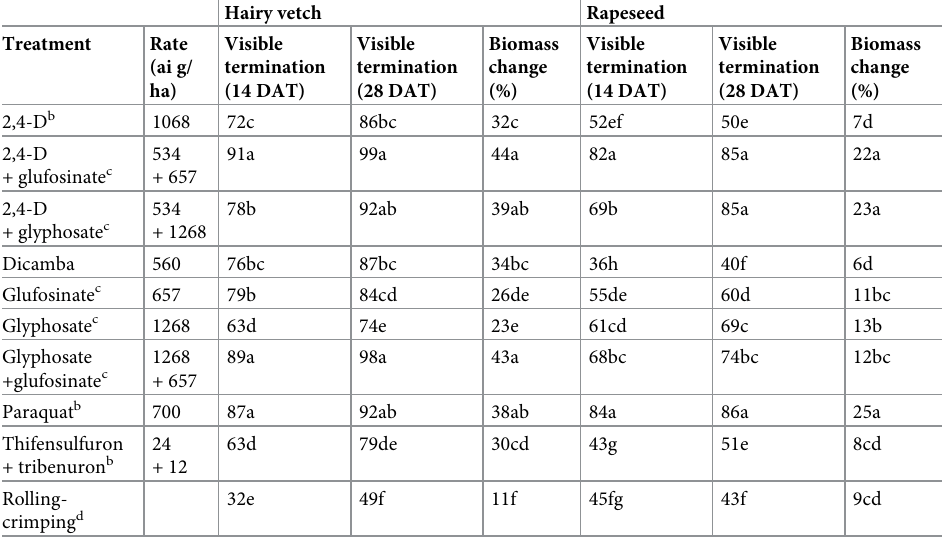
a Visible termination and biomass reduction means with a column followed by the same letter are statistically similar to each other at 5% level of significance b Crop oil concentrate applied at 1% v/v c V-bar roller crimper (I&J Manufacturing, Gordonville, PA) which was hollow from inside, 2.4 m in length, 38